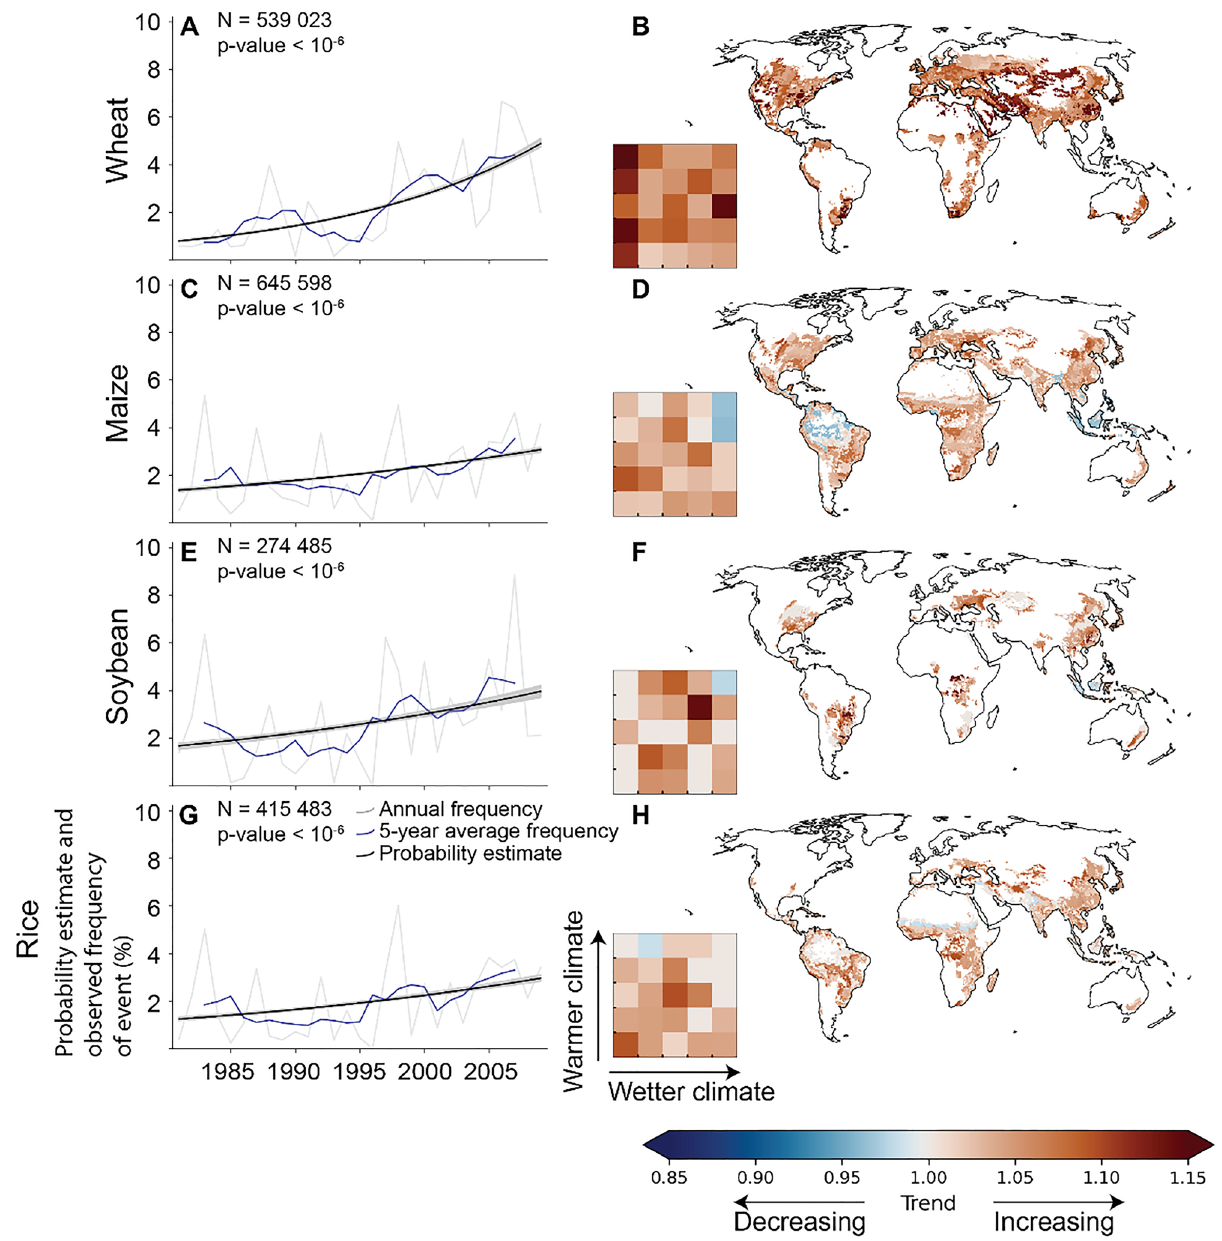
Figure 4. Historical evolution in the probability of co-occurring hot and dry conditions during the growing season between 1980 and 2009. Results are shown for studied crops: wheat ( A , B ), maize ( C , D ), soybean ( E , F ), and rice ( G , H ). Here, a grid cell is considered hot and dry for a specific year, if the number of both hot, and dry days during the growing season deviates at least 1.5σ from the long-term average. The number of hot, and dry days refer to days during the growing season above 90th percentiles for temperature and soil moisture deficit, respectively (i.e. the extreme indicators are calculated separately for each growing season). The historical evolution of the probability in co-occurring hot-dry events was assessed by logistic regression. For the global results ( A , C , E , G ), event frequencies were calculated as a percentage of hot-dry events for each year and as a five-year average, whereas the uncertainty intervals for the regression lines in the figure were calculated by bootstrapping (N = 100) the observations and plotting the regression line for each sample (in gray color). For the climate bins ( B , D , F , H ), the trend obtained from the logistic regression are represented as odds ratios. If odds ratio is above (below) one, the trend is increasing (decreasing). Note that, if the trend was statistically insignificant ( p-value > 0.05) for any of the statistical tests conducted (see “Methods”), the reported odds ratio was set to one (i.e., no trend). The maps presented in the figure were created with Matplotlib and Cartopy Python modules 38–40